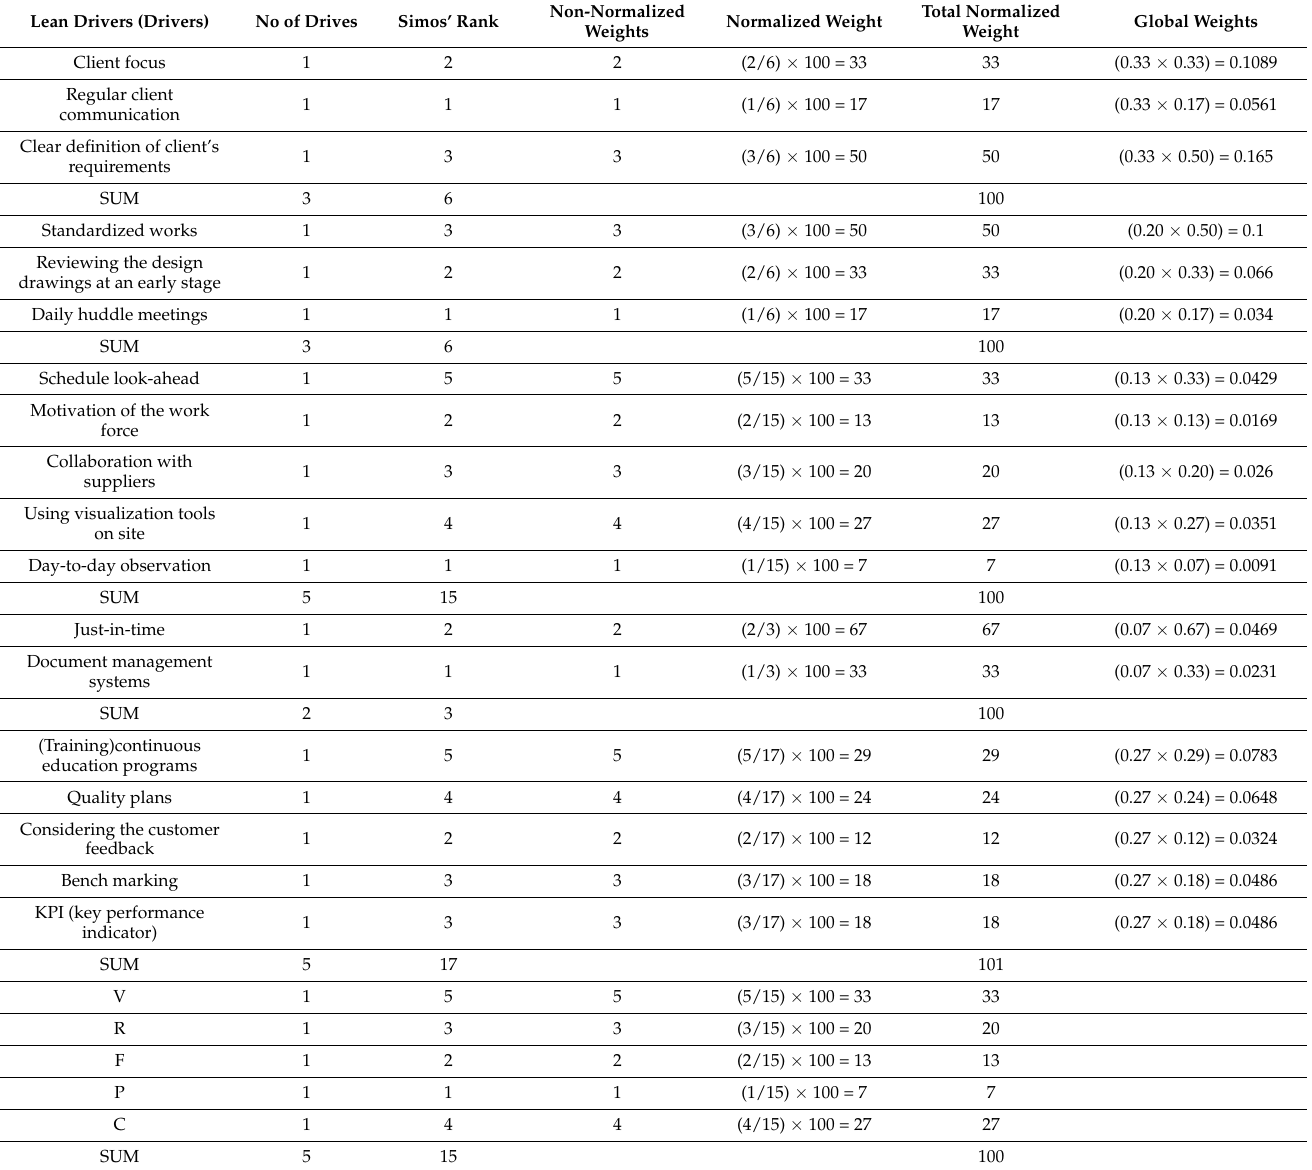
Table 4. Calculation of drivers’